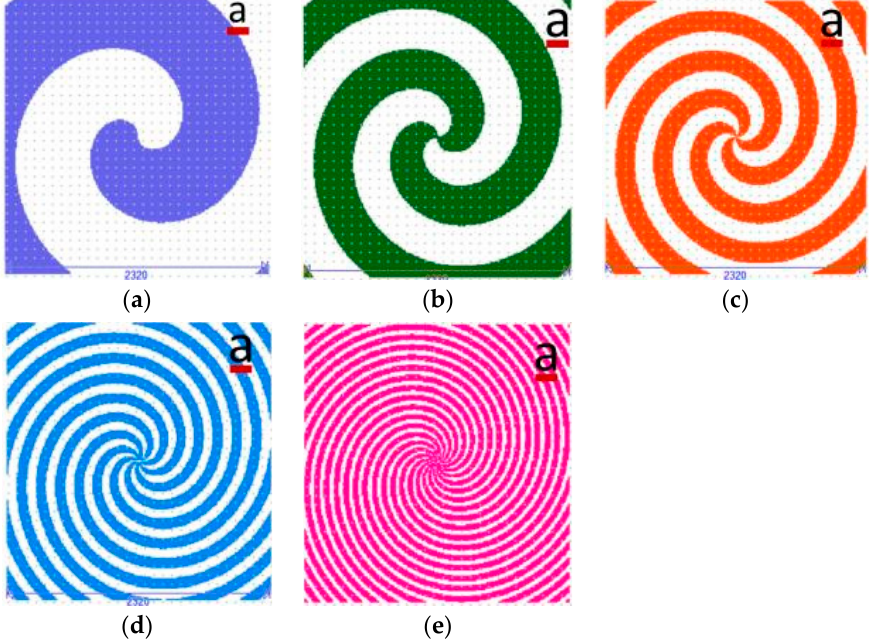
Figure 6. Photolithographic masks for multilevel axicon of order 1 ( a – e ) M1–M5 for five photolith- ographic processes.